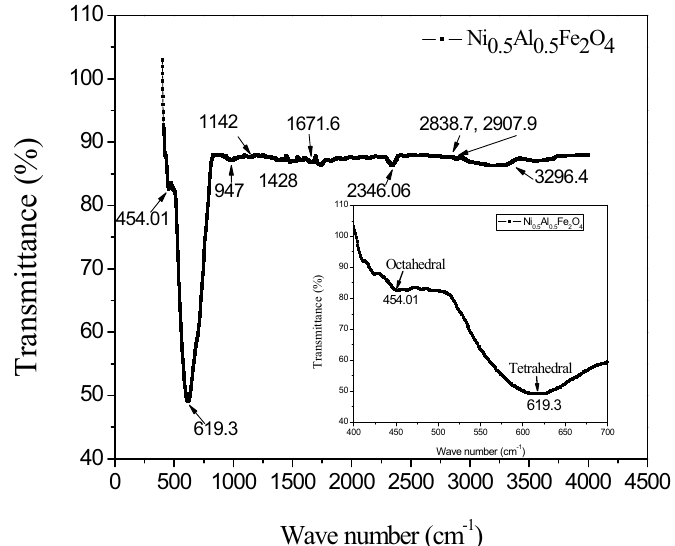
Figure 5. FTIR spectrum of NAFO nanoparticles.